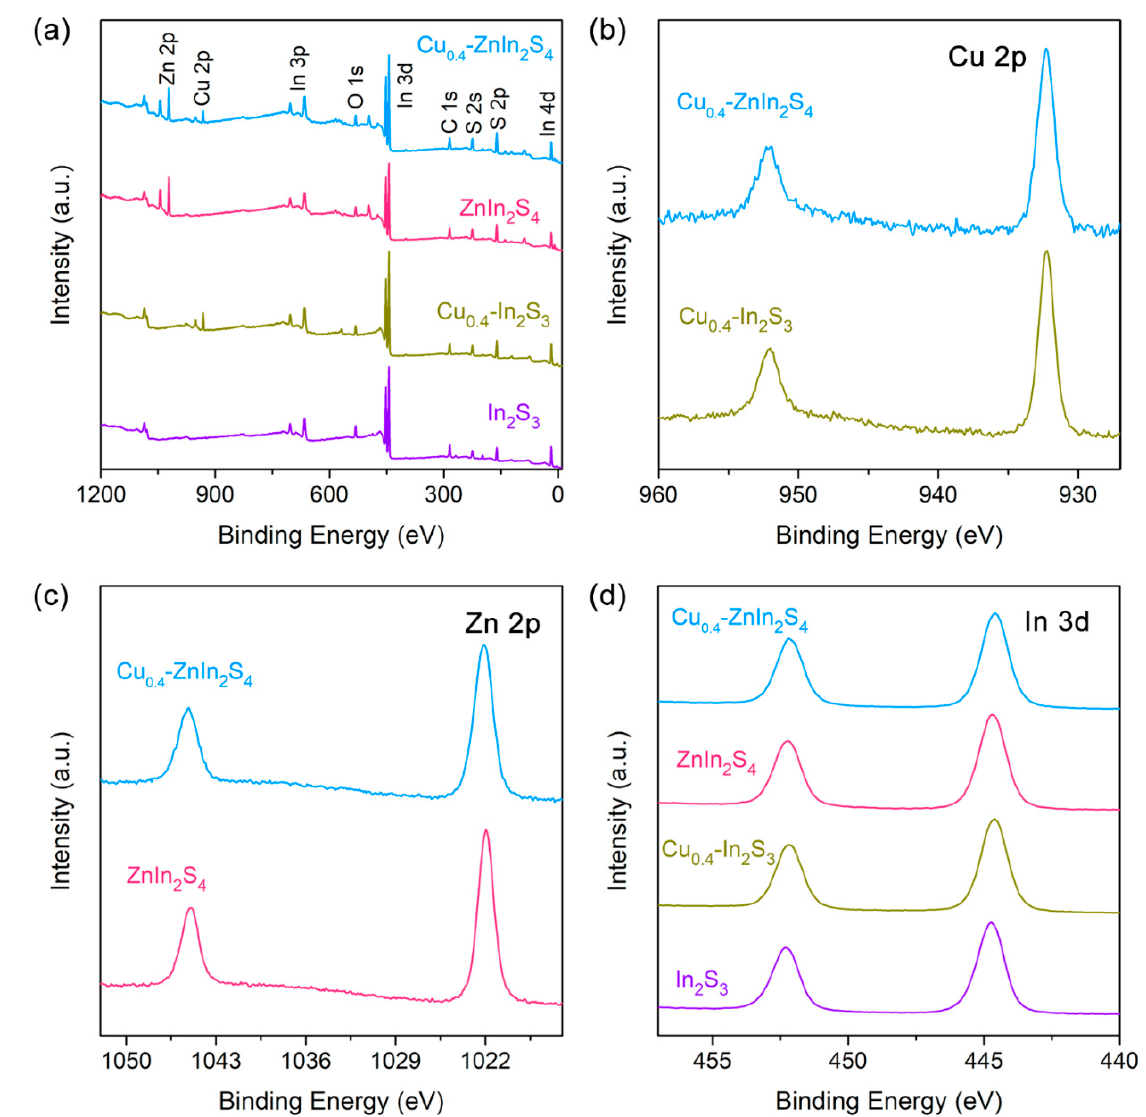
Figure 3. ( a ) The XPS survey spectra of In 2 S 3 , Cu 0.4 -In 2 S 3 , ZnIn 2 S 4 and Cu 0.4 -ZnIn 2 S 4 QDs. The high-resolution XPS spectra of ( b ) Cu 2p, ( c ) Zn 2p and ( d ) In 3d in various QDs, respectively.